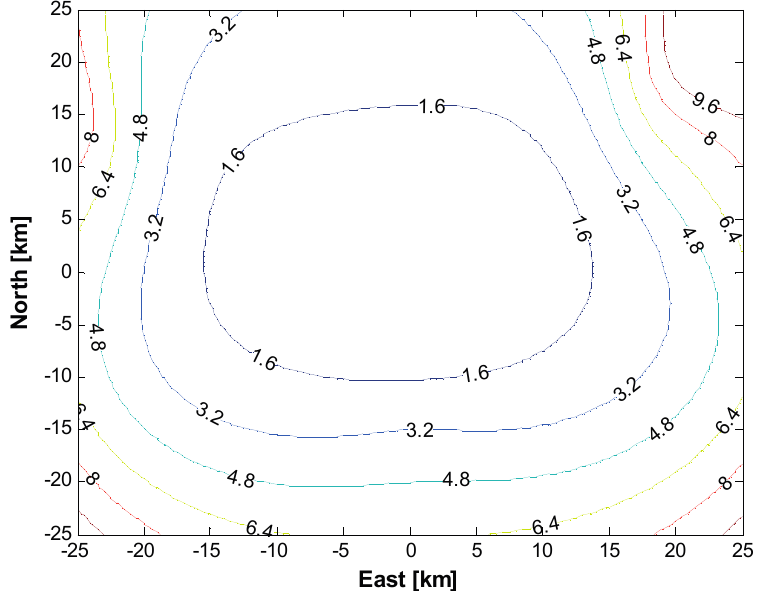
Figure 13. Horizontal dilution of precision (HDOP) of the test